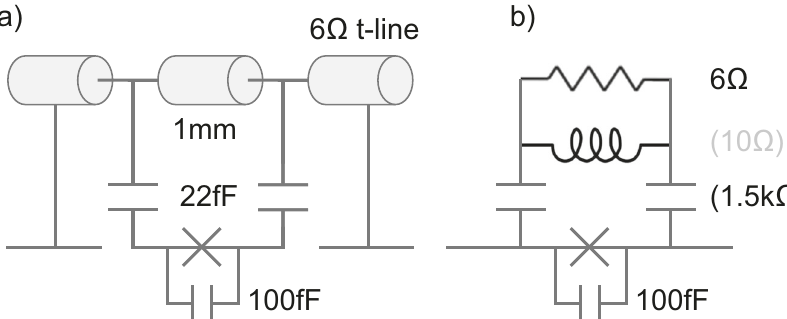
Fig. 7 Equivalent circuit with backside metal. a Circuit showing differential transmon embedded in a ground plane on the qubit layer. The continuous normal metal on the backside then acts as a low impedance transmission line of ~6 Ω impedance, which couples to the transmon via parallel plate capacitors coming from the qubit pads that have an area about 0.1 mm 2 . b Simpli fi ed circuit, replacing the transmission line with an equivalent resistor, and the short transmission line between capacitors with an inductor, with impedances at 5 GHz shown in parenthesis. This heavily damps the qubit with a Q ~ 1